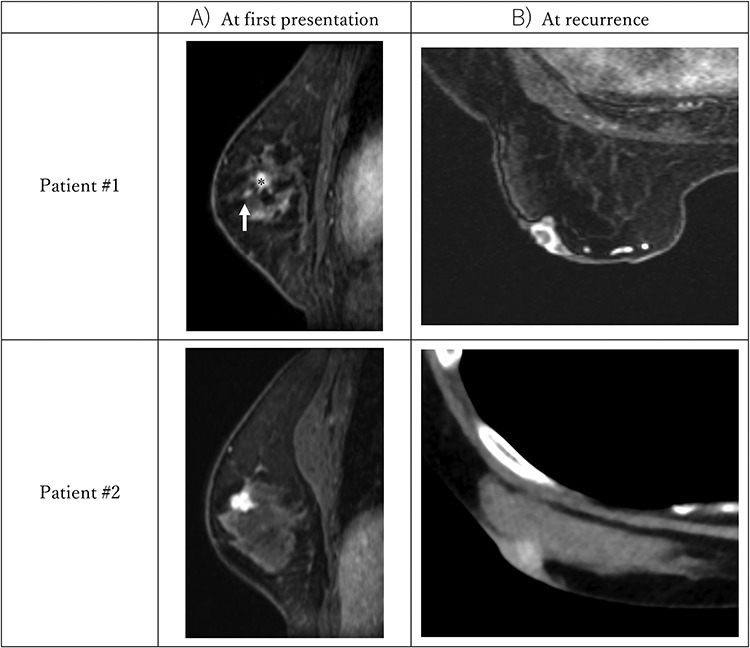
Dynamic contrast-enhanced MRI images of patients #1 and #2 (Table 2) at first presentation and MRI or CT image at recurrence. (A) Sagittal view of delayed-phase (~5 min after gadolinium injection) T1-weighted image (T1WI) of primary tumor at first presentation. Patient #1: a small enhanced nodule (↑) is captured in the nipple direction which indicates the EIC of the primary tumor (*). Patient #2: a 1.2 cm enhanced tumor is captured. In this view, the EIC is not completely clear, but as shown in Fig. 2, the axial view is suspected of having EIC. (B) Delayed-phase T1WI (achieved in the prone position) of patient #1 at recurrence and contrast enhanced CT image (achieved in the supine position) of patient #2 at recurrence. Enhanced tumor just under the nipple is captured in both patients.